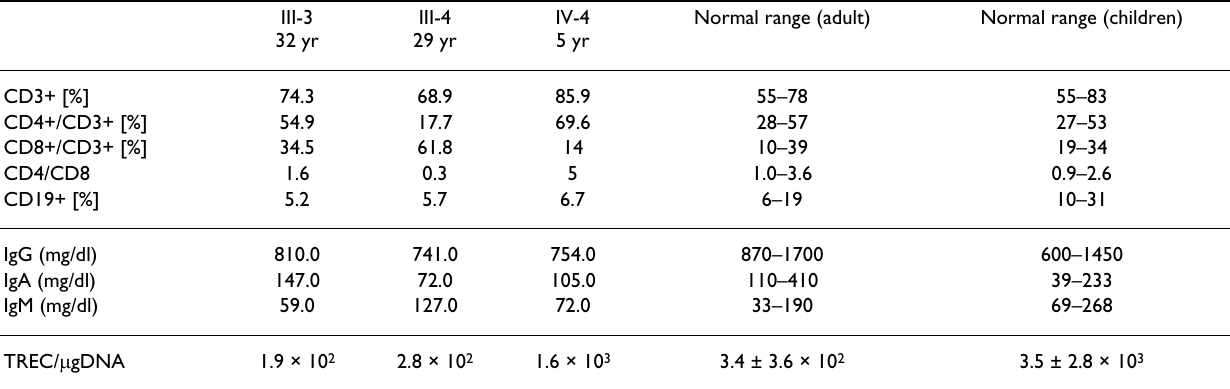
Table 2: Immunological evaluation of NDI patients